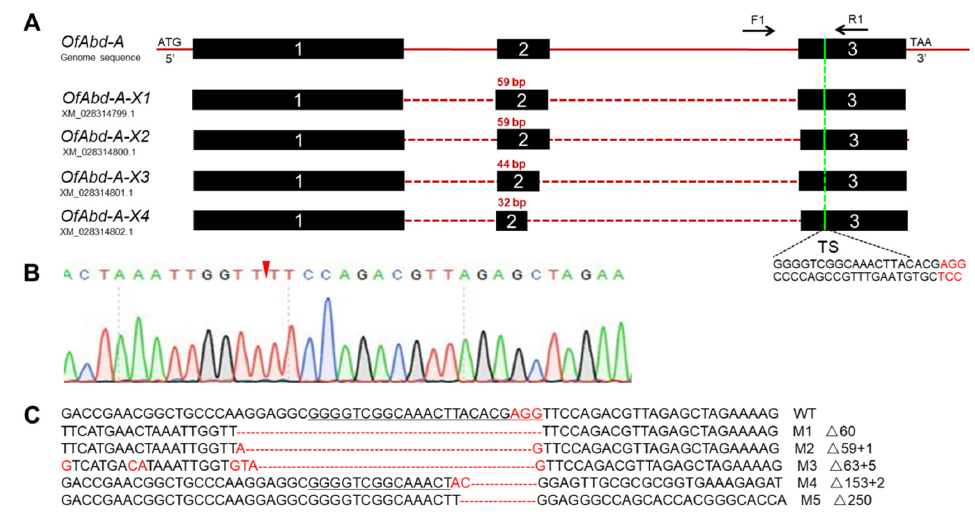
Figure 4. CRISPR/Cas9-mediated mutations within OfAbd-A target sites. ( A ) Target site of OfAbd- A genome locus focused on the third exon of the common region in the four splice variants. ( B ) Sequencing chromatogram of OfAbd-A mutants. The red wedge indicates position of cleavage by the CRISPR/Cas9 genome editing system. M1 (Mutant 1); M5 (Mutant 5). ( C ) Mutations detected by sequencing. The PAM sequence is in red. The black line represents the target site.